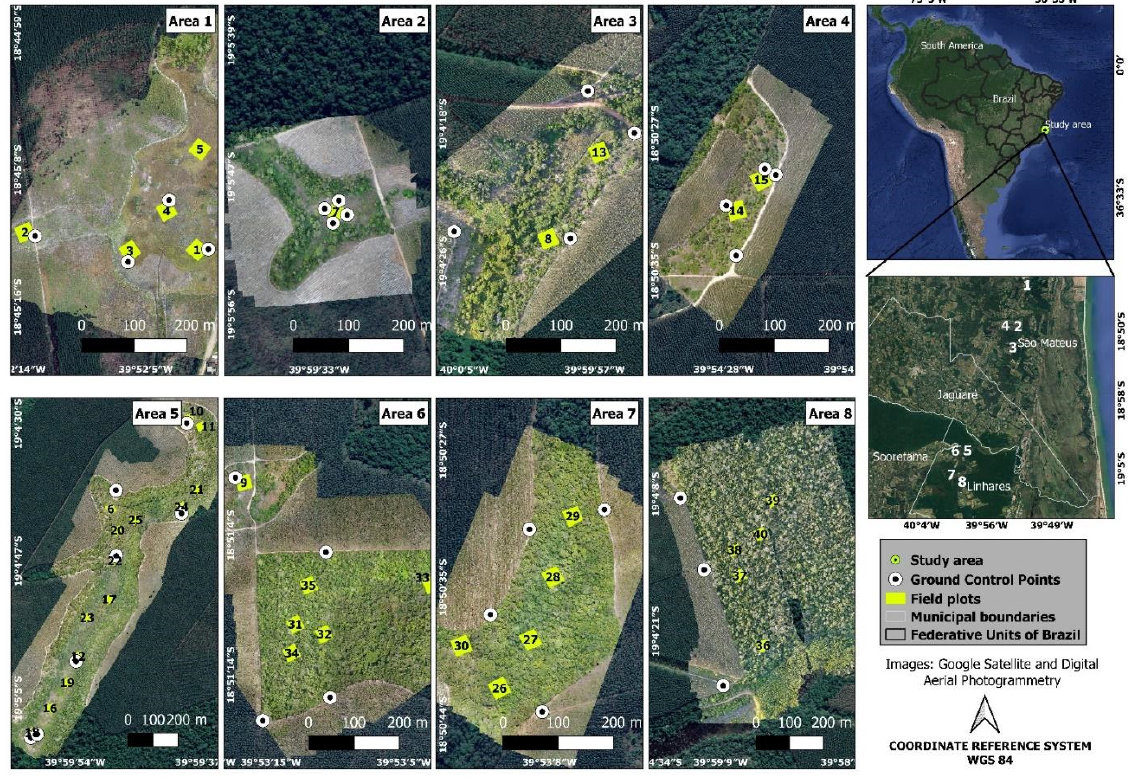
Figure 1. Location of the study area and their field plots.